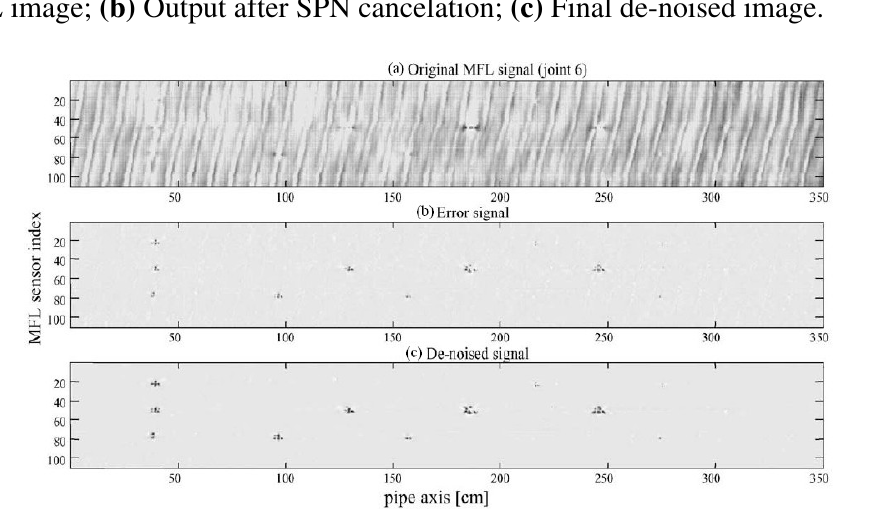
Figure 3. Results obtained from the application of the noise cancelation algorithm [8]. (a) Raw MFL image; (b) Output after SPN cancelation; (c) Final de-noised